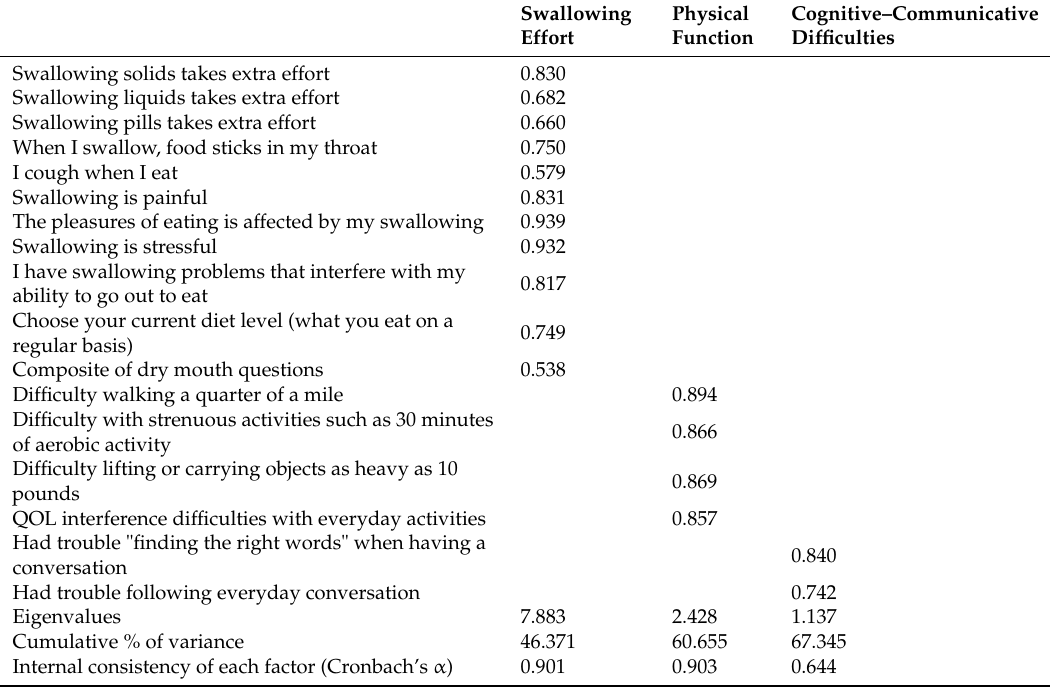
Table 3. Exploratory factor analysis results. Construct validation of the scale completed via exploratory factor analysis (principal components analysis with direct oblimin rotation). Three factors extracted, items in each factor bolded. Factors determined to represent swallowing function, physical function, and